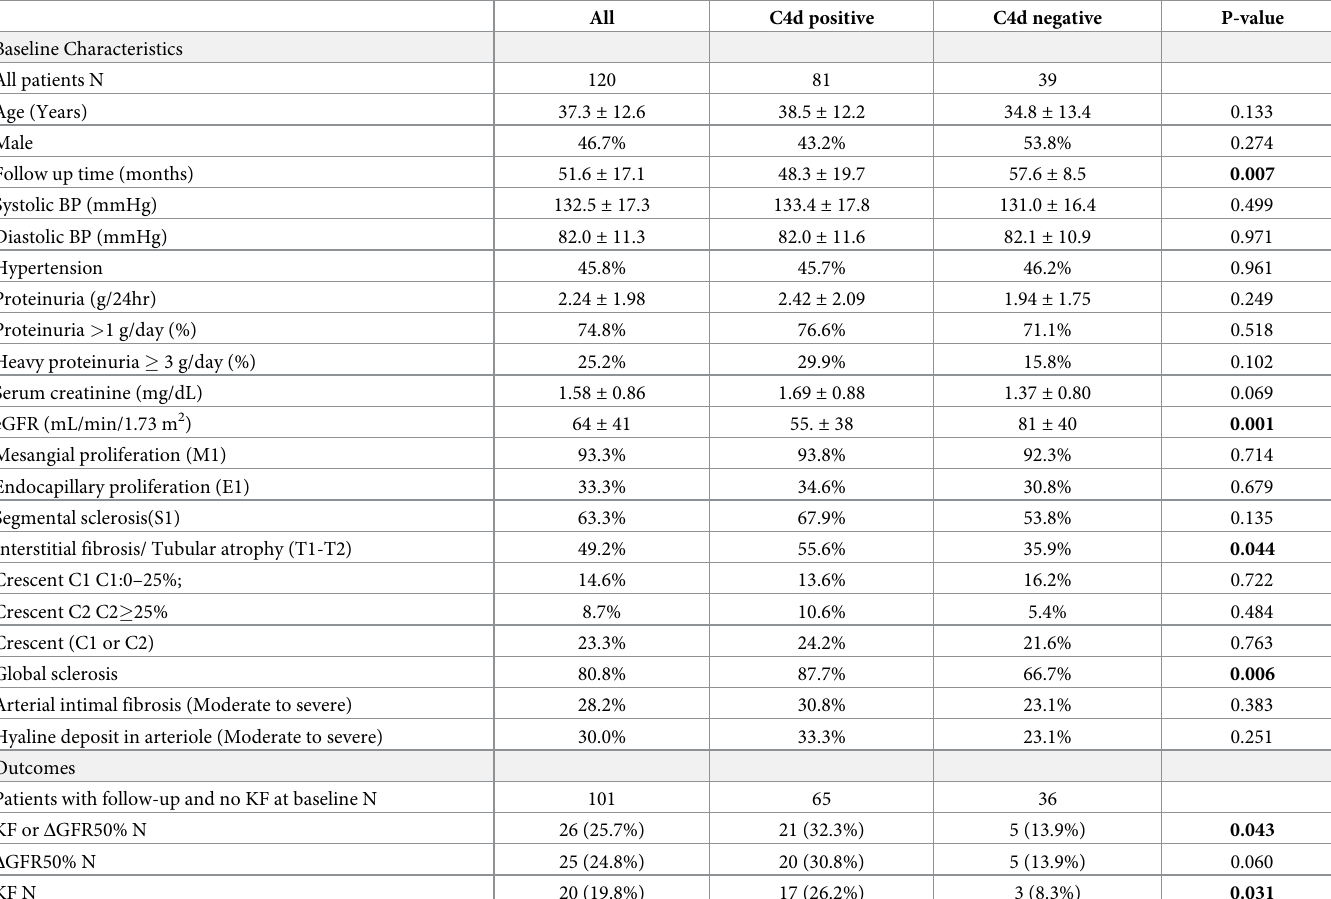
Table 1. Clinicopathological data at the time of kidney biopsy and outcomes at follow-up by positive or negative C4d staining.